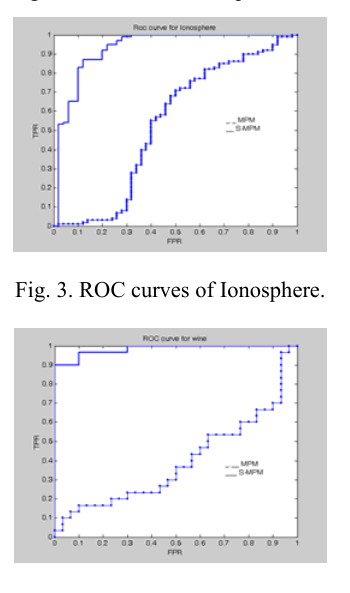
Fig. 4. ROC curves of Wine.